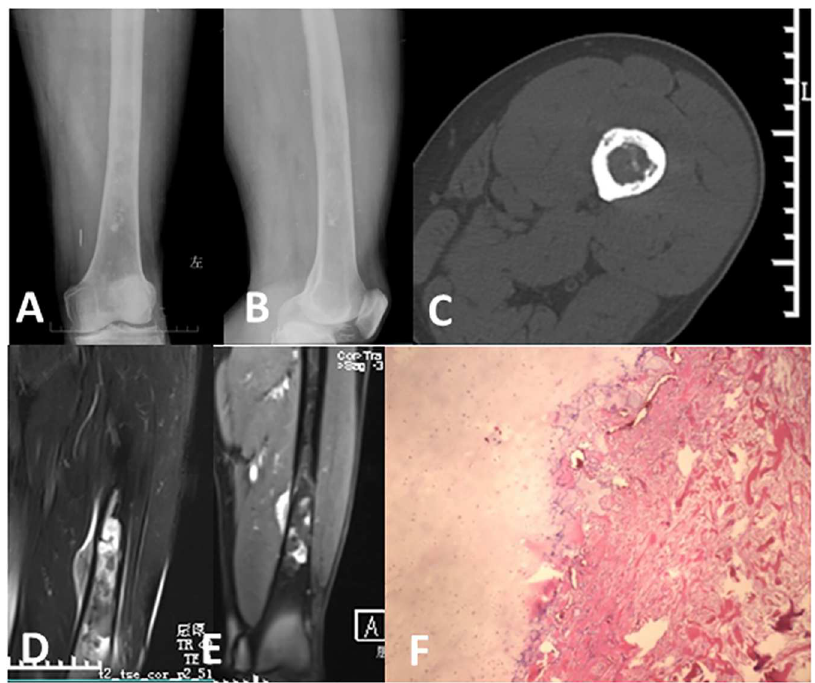
Fig 2. Dedifferentiated chondrosarcoma of the left distal femur in a 73-year-old man (Case 4). (A,B). Anteroposterior and lateralradiographs demonstrated chondral matrix mineralization, showinga low-grade chondral tumor but no signsof cortical destruction. (C). CT showedpermeating cortical destruction. (D). Fat- suppressed axial T2-weighted imageshowedextra-osseous soft tissue with reducedsignalintensity,prompting a dedifferentiatedcomponent. (E). Enhanced MRI showedpunctate,ring or septalenhancement in the intraosseous chondral tumor component and heterogeneous evidentenhancement in the extra-osseous dedifferentiatedcomponent.(F). Photomicrograph (HE stainingX40) showingthe biphasicpattern of low grade chondrosarcomaand highgrade osteosarcoma. This patient underwent preoperative and postoperative chemotherapy; however,tumor necrosisof the lesionwas onlyapproximately60% on histology.One year later, the patient suffered from lung andmultipleorganmetastasisand diedafter five months.